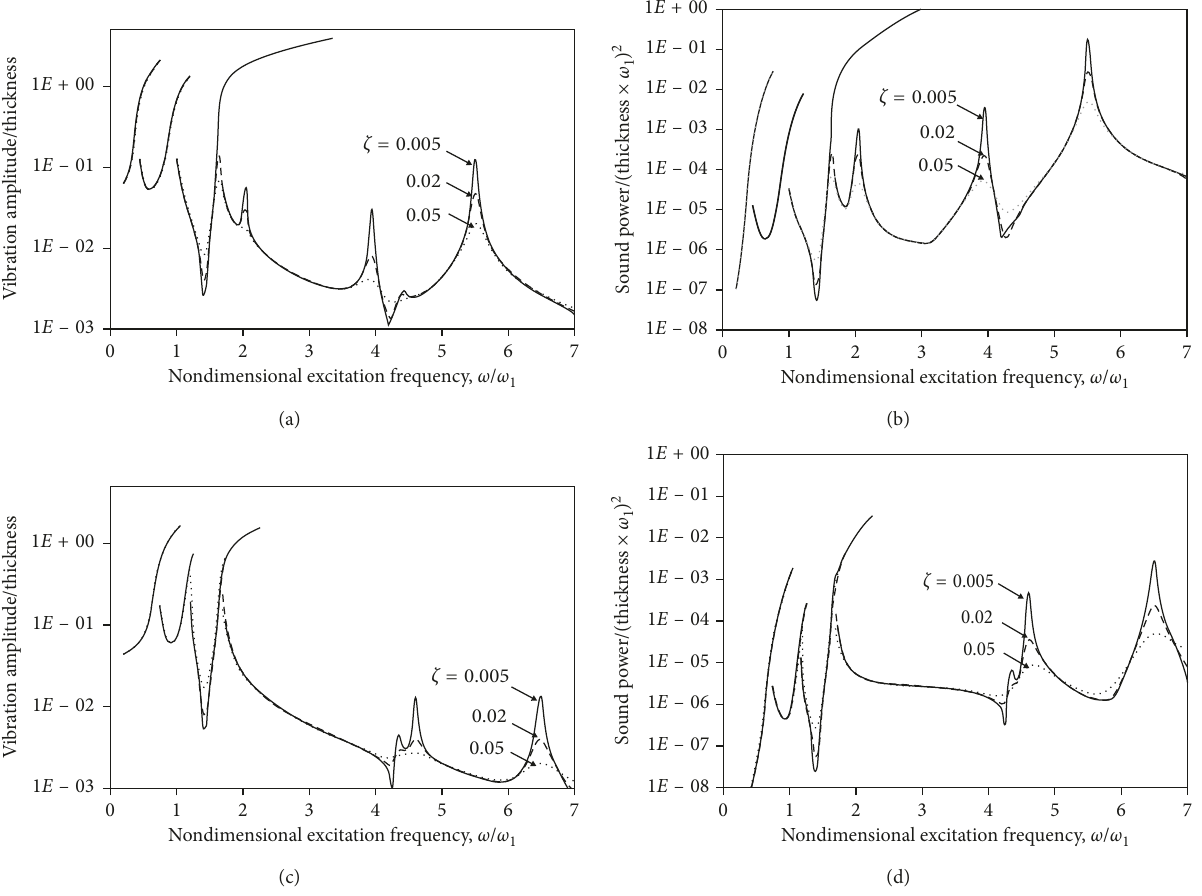
Figure 4: (a) Symmetric and (c) antisymmetric vibration amplitude versus excitation frequency for various damping ratios ( κ